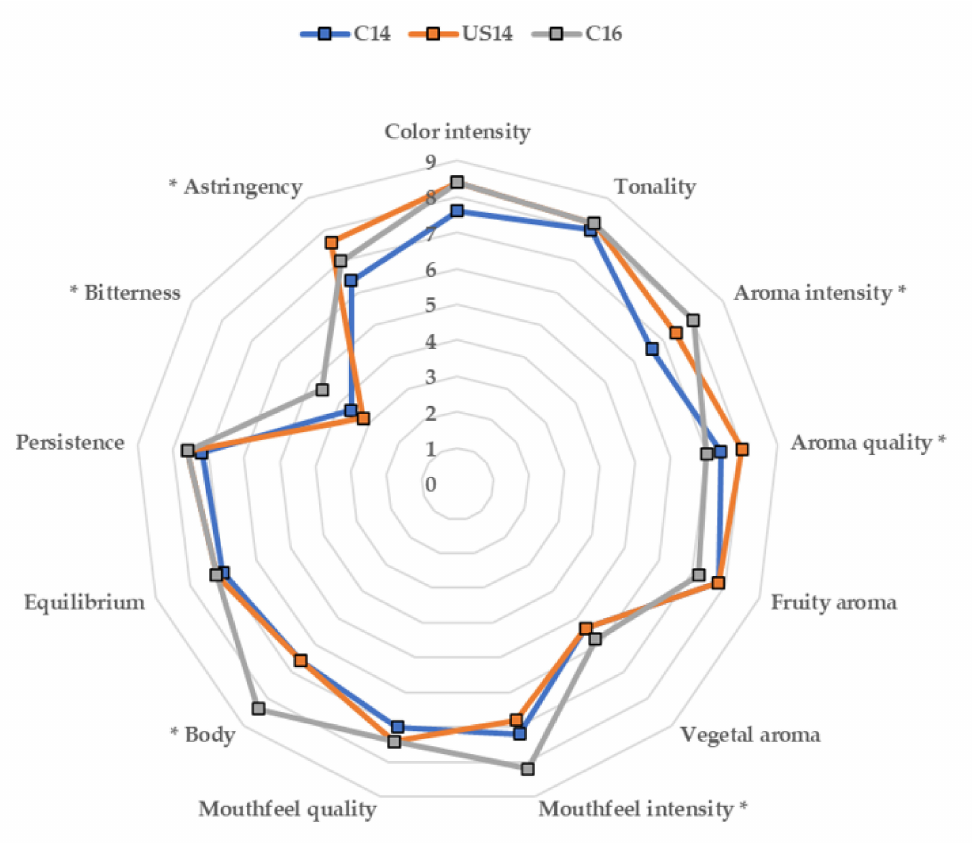
Figure 1. Descriptive sensory analysis of the three di ff erent wines (* denotes significant di ff erences p <